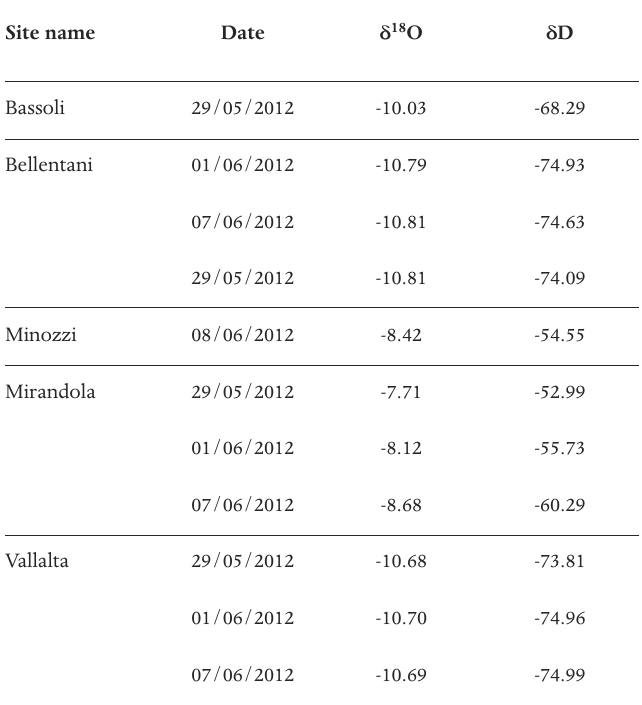
and deuterium) for 2